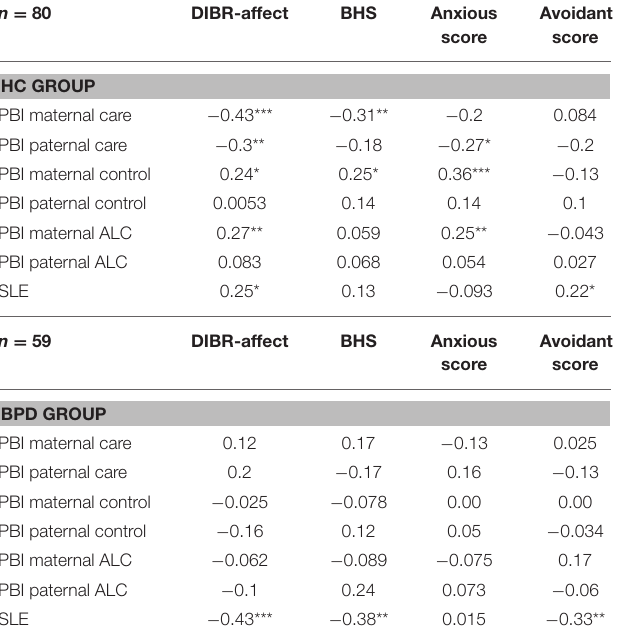
TABLE 2 | Correlations between adversity, affective symptoms, hopelessness, and attachment in BPD and HC groups. n = 80